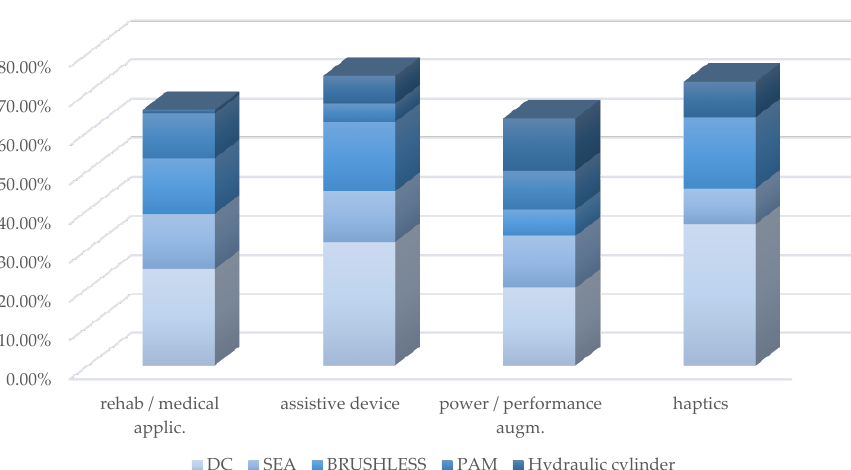
Figure 23. The distribution of the most used actuator types for exoskeletons with different purpose. The brushed DC motor is the most frequent choice for all the EDs purposes (25%, 32%, 20% and 36%, in the displayed order). For medical EDs SEAs, brushless and PAMs also have a quite similar weight (14%, 14% and 12%). Brushless in assistive devices have quite significant diffusion (18%). Hydraulic cylinders have a percentage of 13% in EDs for power/performance augmentation.